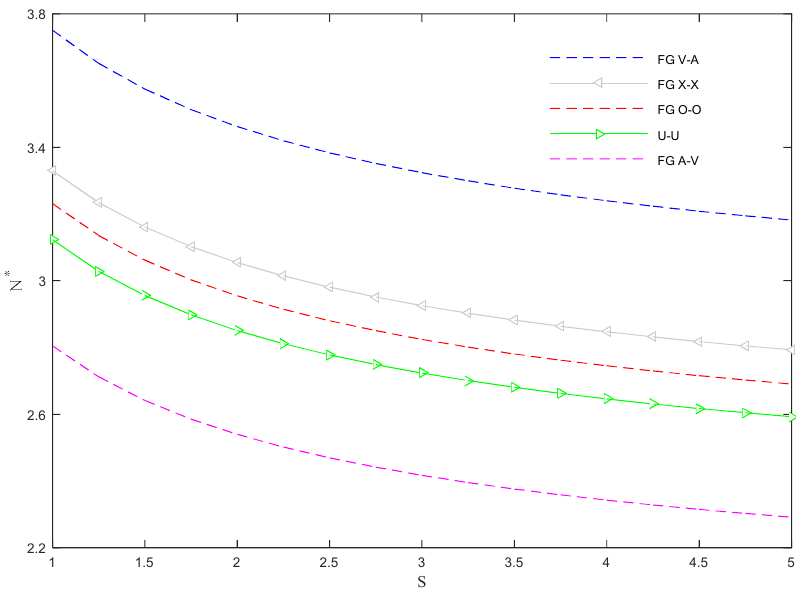
Figure 9. Dimensionless critical buckling load versus power-law index for different CNTs’ distribution patterns within the CNTRC skins.